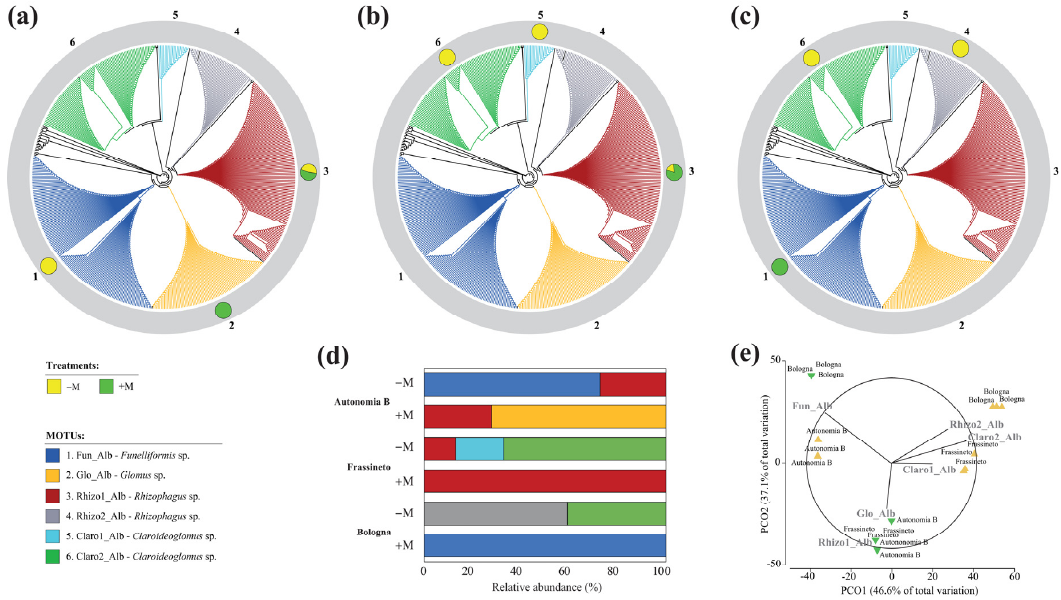
Figure 7. Neighbor-Joining trees of 504 AMF sequences retrieved in the uninoculated and inoculation roots of Autonomia B ( a ) Frassineto ( b ) and Bologna ( c ) and of 31 AMF reference sequences. For each MOTU, the proportion of sequences retrieved in the mock inoculated ( − M) and inoculated roots ( + M) are represented by the pie charts in ( a – c ). Relative abundances of AMF MOTUs found within the roots of Autonomia B, Frassineto and Bologna ( d ). Principal Coordinates analysis on the e ff ect of AMF inoculation and wheat genotype on AMF community diversity. In the PCO biplot, the AMF MOTUs are displayed as arrows. The circle with a diameter is 1.0 and allows the reader to understand the scale of the vectors in the vector plot ( e ).